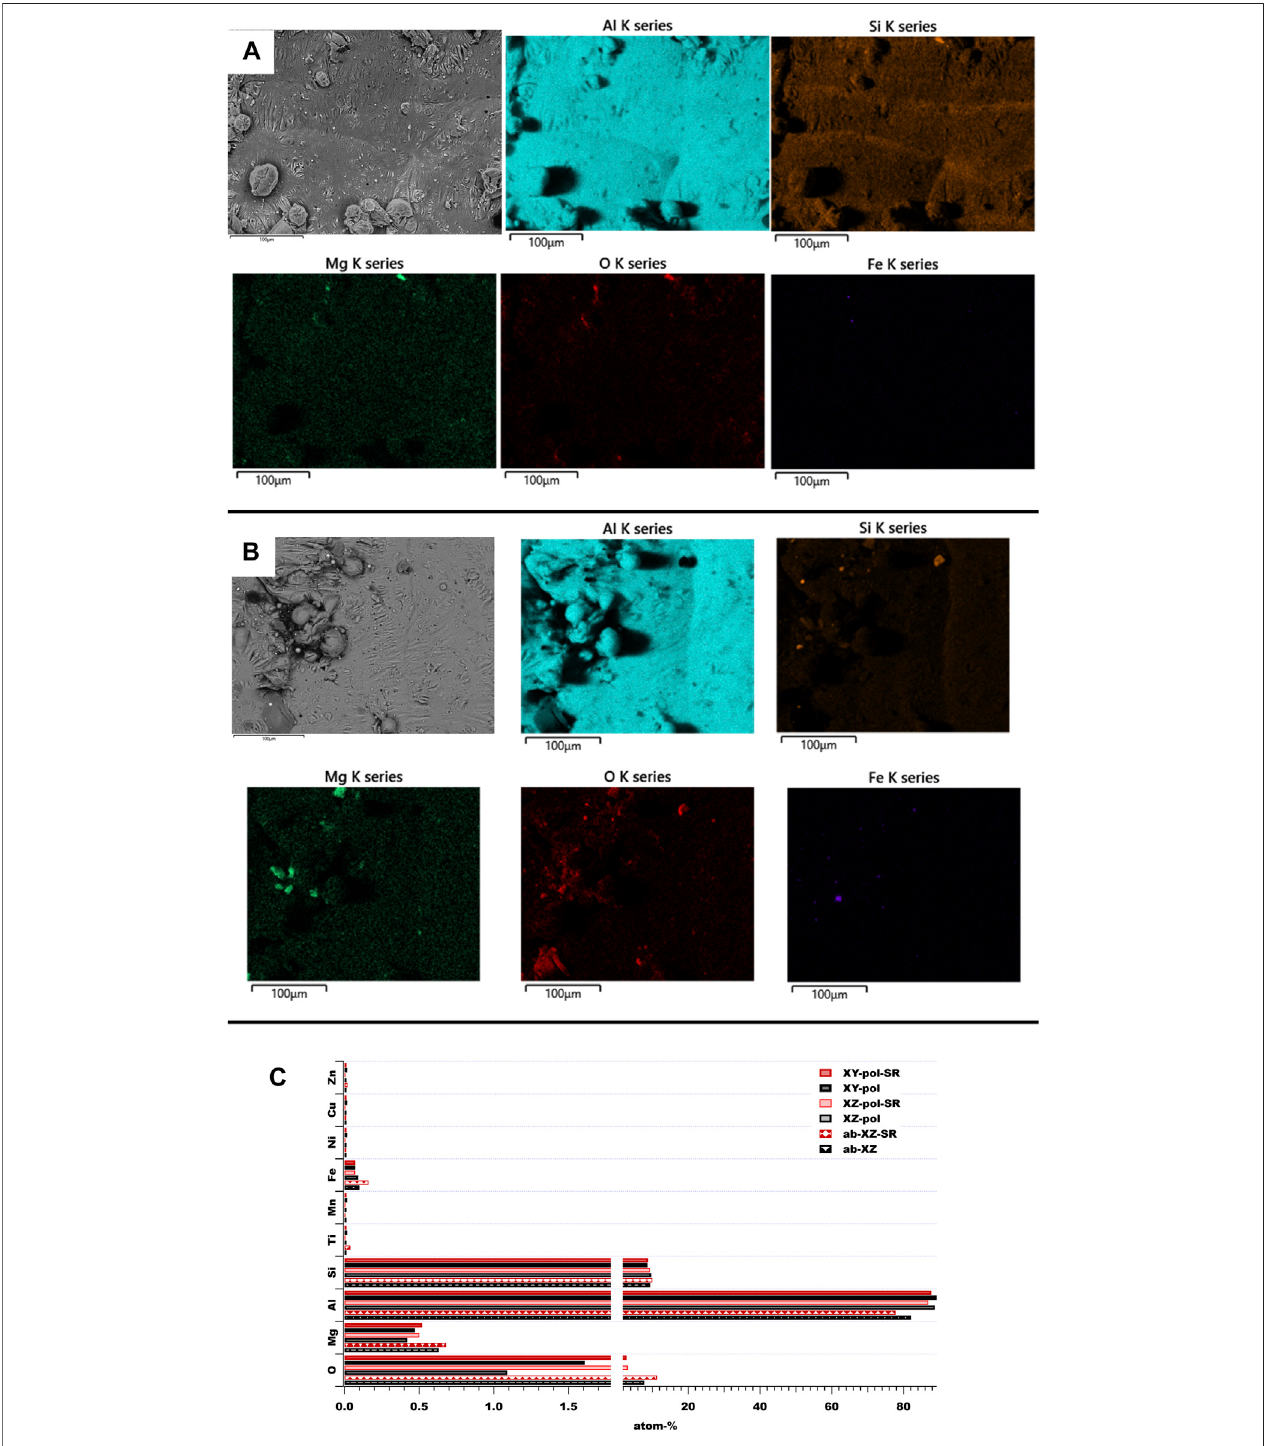
FIGURE 1 | SEM and EDS analysis of as-built surfaces: (A) as-built XZ surface; (B) as-built XZ SR surface; (C) elemental overall contribution of these surfaces.